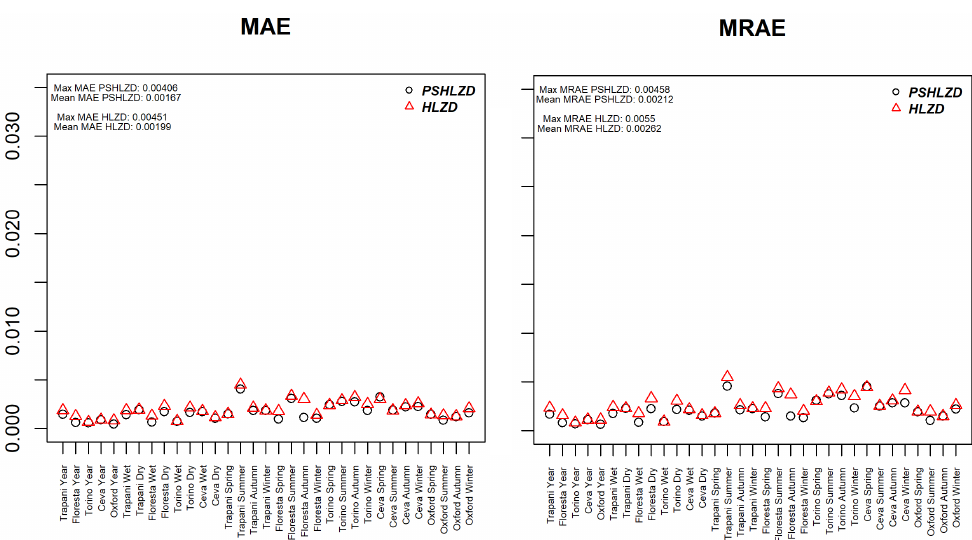
Figure 7. Dot plots of MAE and MRAE taking as reference the cdf of the PSHLZD (black circle) and of the HLZD (red triangle) for all the h samples. The maximum MAE as well as the mean MAE are given in the top left for both the fitting